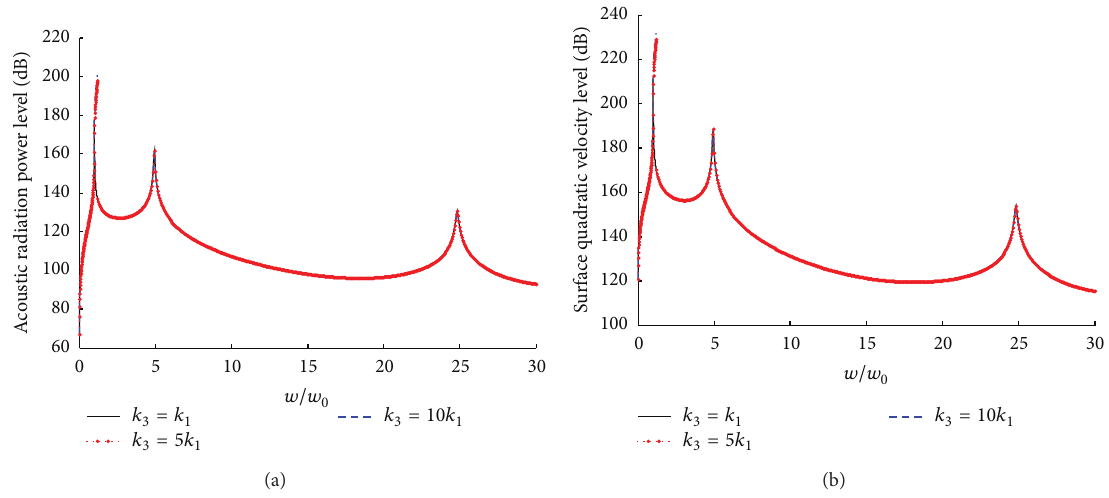
Figure 4: Influence of the nonlinear stiffness on the vibroacoustic properties of the plate: (a) acoustic radiation power level and (b) surface quadratic velocity